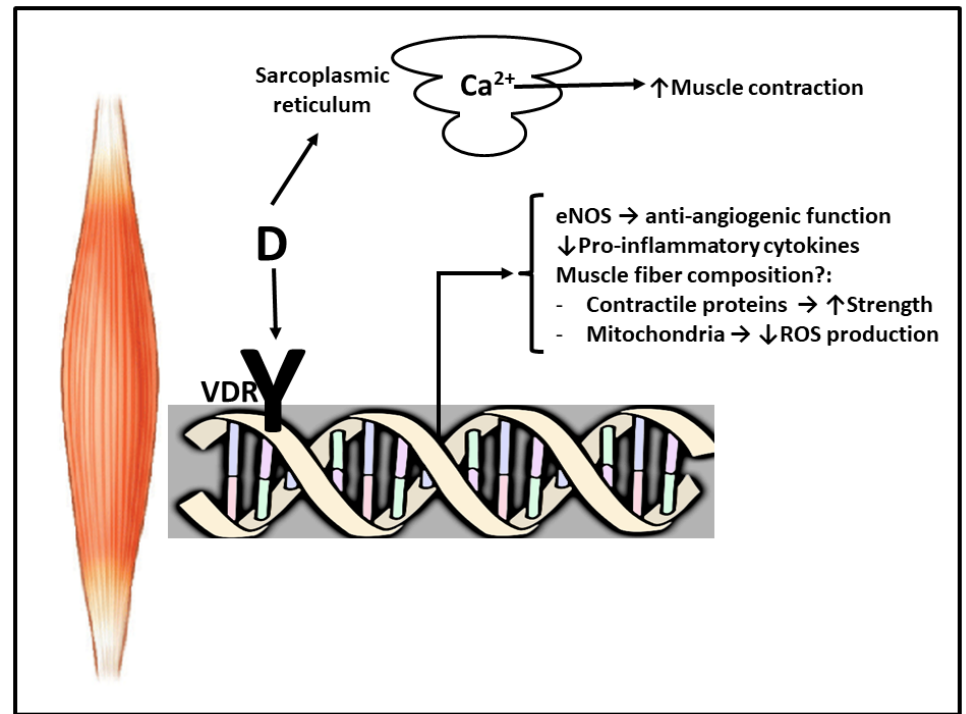
Figure 1. Scheme of genomic and non-genomic actions of vitamin D on skeletal muscle. Genomic actions imply binding of vitamin D (D) to the receptor (VDR). ( ↓ ) Indicates decreased expres- sion/formation, ( ↑ ) indicates improvement/increase (?) indicates that additional research is